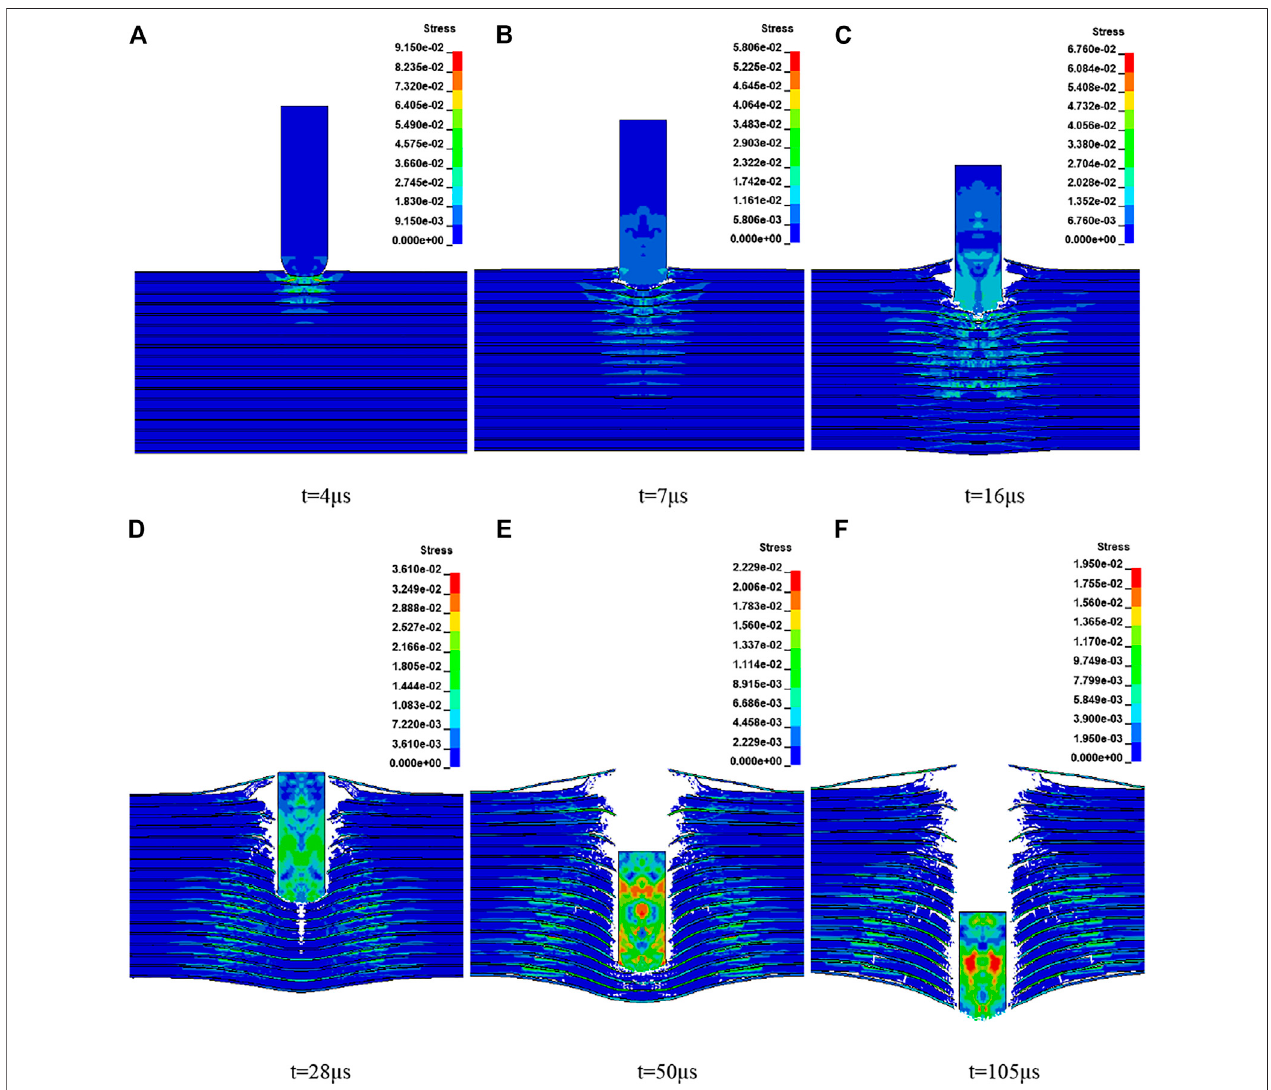
FIGURE 8 | Stress nephogram of TC4-Al 3 Ti-Al targets under 1100 m/s bullet velocity. (A) t = 4 µs, (B) t = 7 µs, (C) t = 16 µs, (D) t = 28 µs, (E) t = 50 µs, (F) t = 105 μ s.